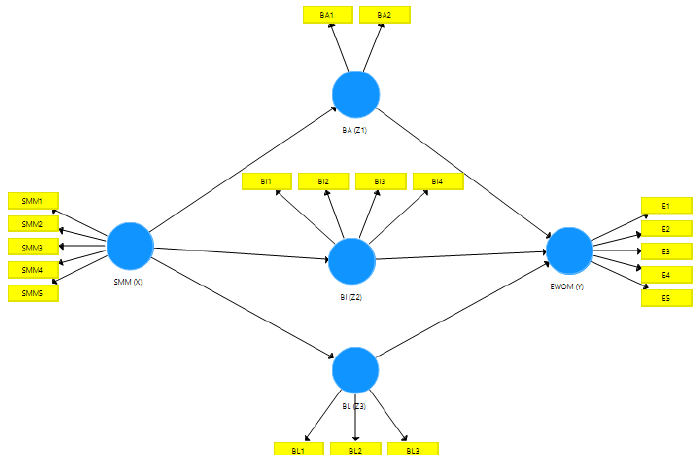
Fig. 2. Path Diagram of the Influence of Social Media Marketing on